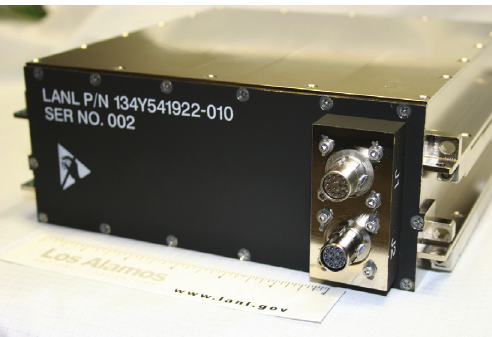
Figure 11: Completed, sealed T-SDR system with satellite inter- faces.